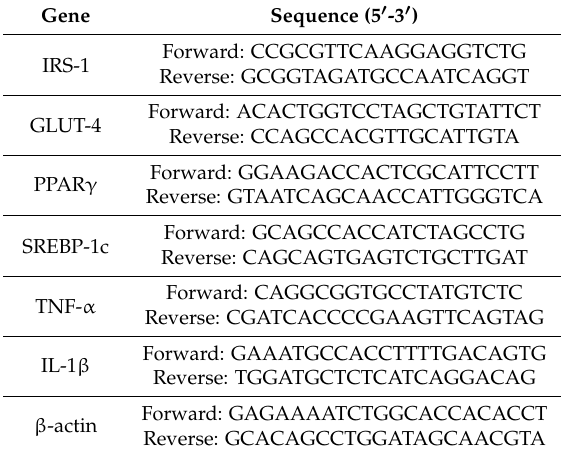
Table 1. Primer sequences of genes; IRS-1: Insulin receptor substrate; GLUT-4: Glucose transporter type 4; PPAR γ : Peroxisome proliferators-activated receptor γ ; SREBP-1c: Sterol-regulatory element-binding protein-1c; TNF- α : tumor necrosis factor α ; IL-1 β : Interleukin 1 β .